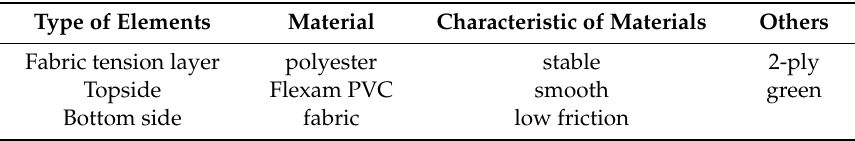
Table 1. The characteristics of the conveyor belt (based on [20]).